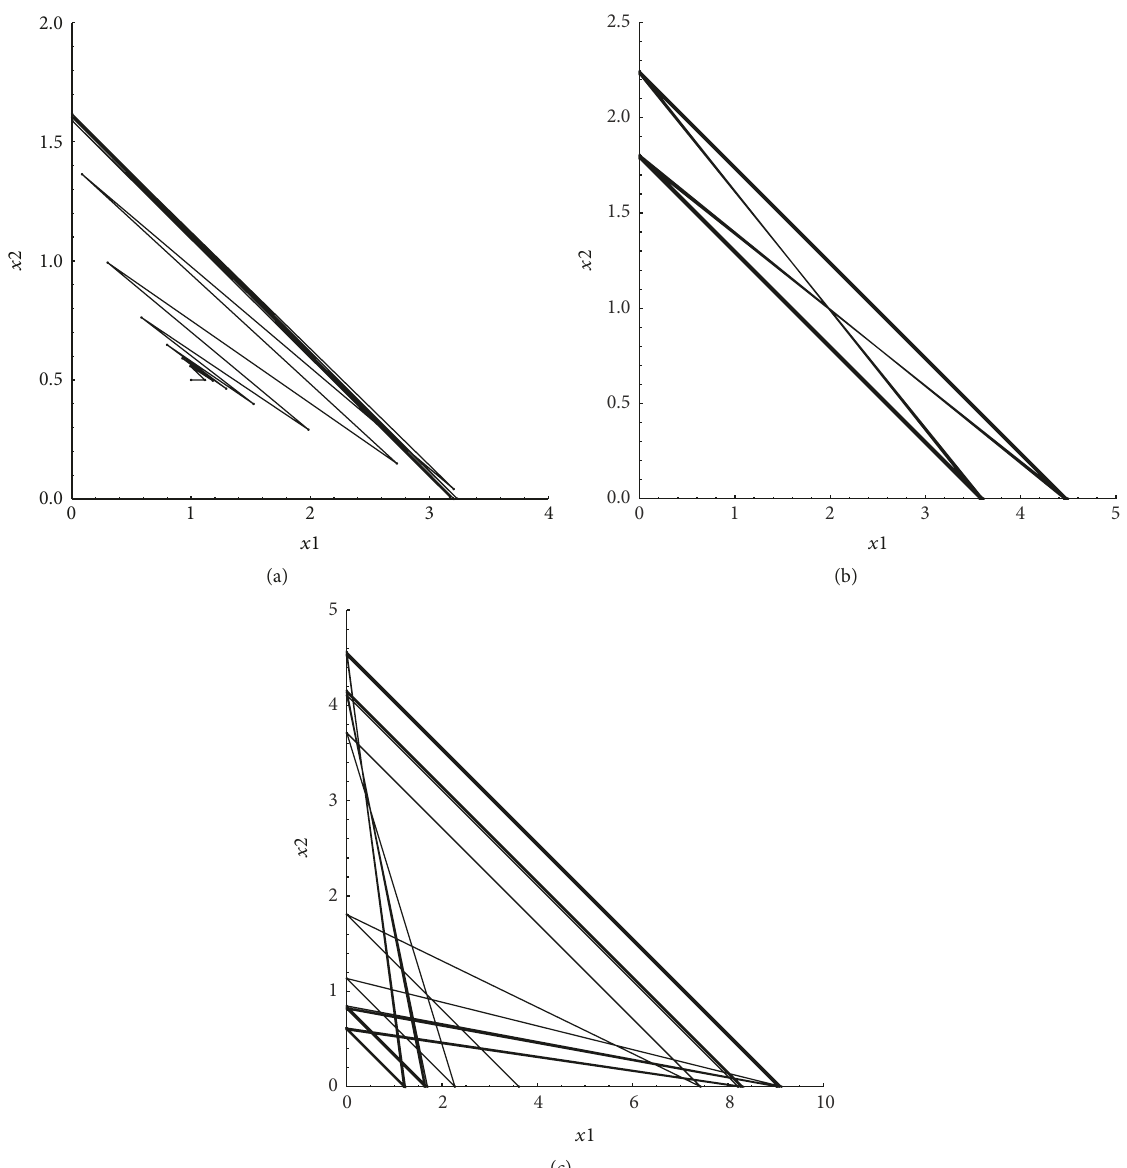
Figure 1: (a) An orbit approaching the SYC 2-cycle (𝑃 −1 ln 𝑅 0 .0) , (0, ln 𝑅 0 ) . Parameter values (𝛼,𝛽) = (1,0) , (𝑃,𝐹) = (0.5,10) . (b) A 4-cycle on SYC form. (𝛼,𝛽) = (1,0) , (𝑃,𝐹) = (0.5,15) . (c) Chaotic SYC dynamics. (𝛼,𝛽) = (1,0) , (𝑃, 𝐹) = (0.5, 25) .